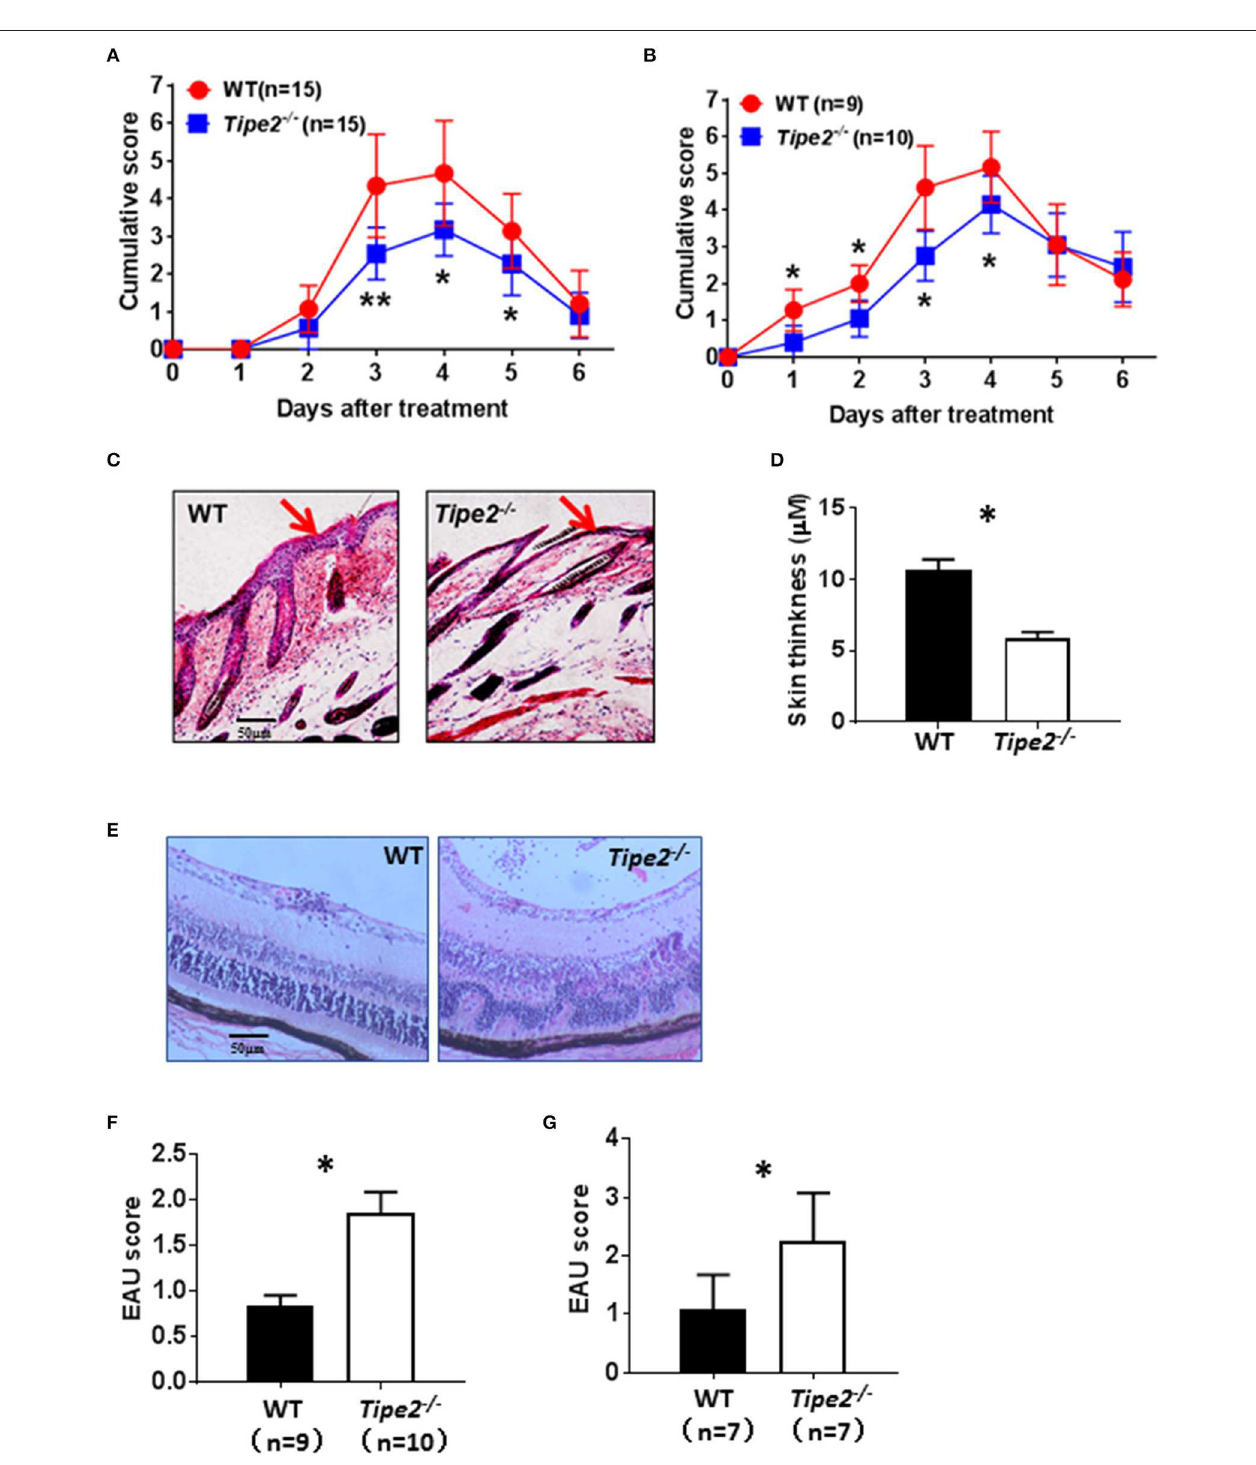
FIGURE 1 | TIPE2-deficiency alleviates psoriasis but promotes the development of EAU. (A) WT ( n = 15) and TIPE2-deficient ( n = 15) mice in the C57BL/6 background were treated with IMQ cream on the shaved back skin as mentioned in the Materials and Methods. Mice were monitored for the development of erythema and scaling on the back skin. The cumulative score (erythema plus scaling) is depicted. Data were combined from two separate experiments. (B) Total T cells were isolated from wild-type and TIPE2-deficient mice and adoptively transferred to Rag1 − / − mice (10 × 10 6 /mouse). IMQ cream was used to induce psoriasis as mentioned in the Materials and Methods. The cumulative score (erythema plus scaling) was calculated as mentioned in (A) . Data were